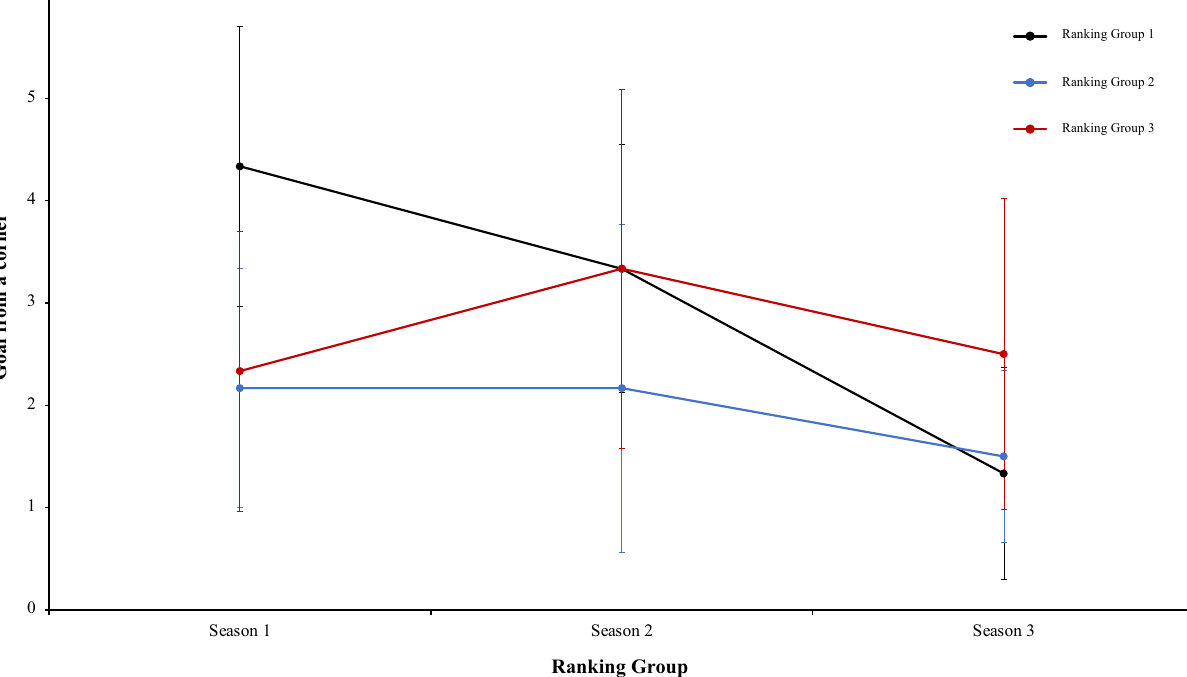
Figure 21. Technical performance. Mean total goal forma a corner (± SE) as a funtion of Ranking and Season Condition.